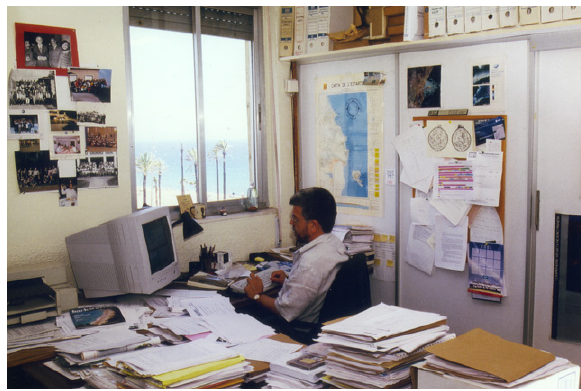
Fig. 3. – Jordi Font at his office in the original ICM building in